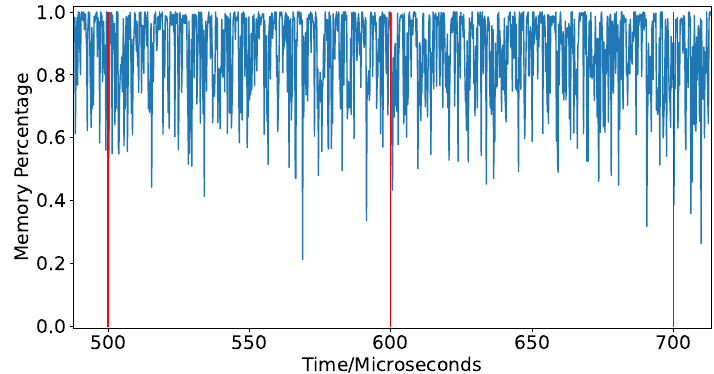
Figure 2. A running fragment of 619.lbm .